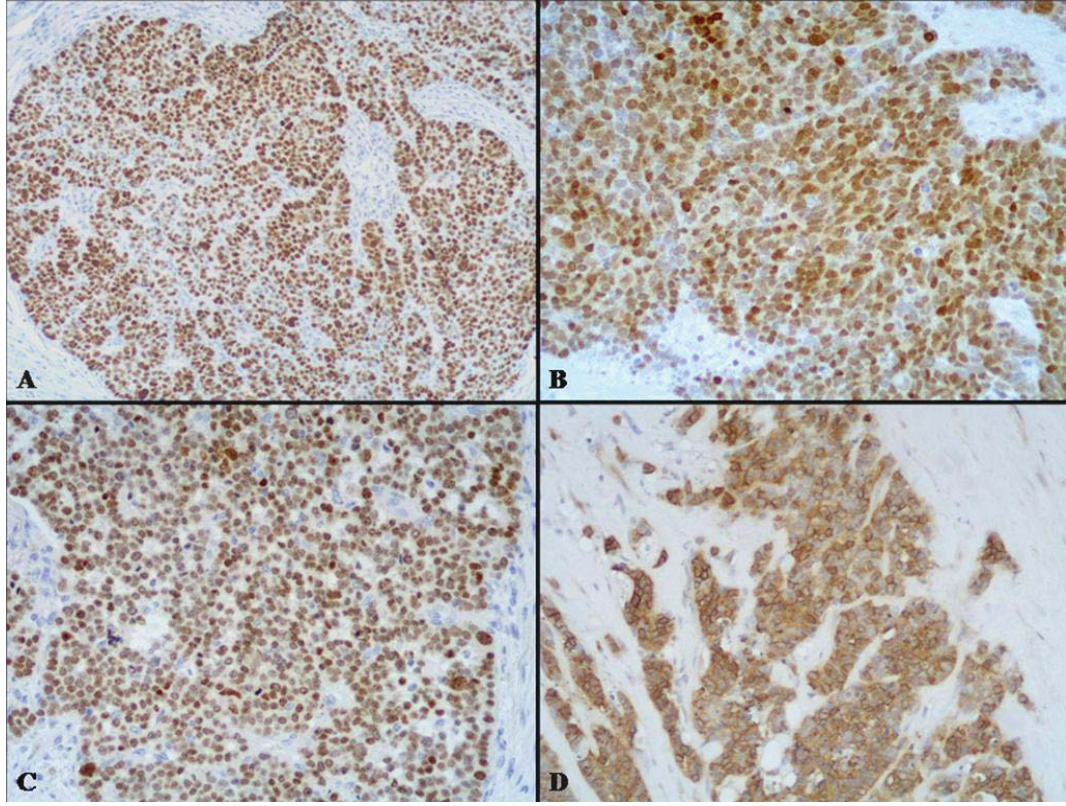
Figure 6. The neuroendocrine component of high grade MANECs generally shows p53 nuclear immunoreactivity ( A ). In addition, CDX2 ( B ) and TTF1 ( C ) nuclear positivity can be also demonstrated in neoplastic cells. CD117 immunoreactivity can be observed in some cases and its expression has been recently demonstrated to be associated with worse patient outcome in colorectal MANECs ( D